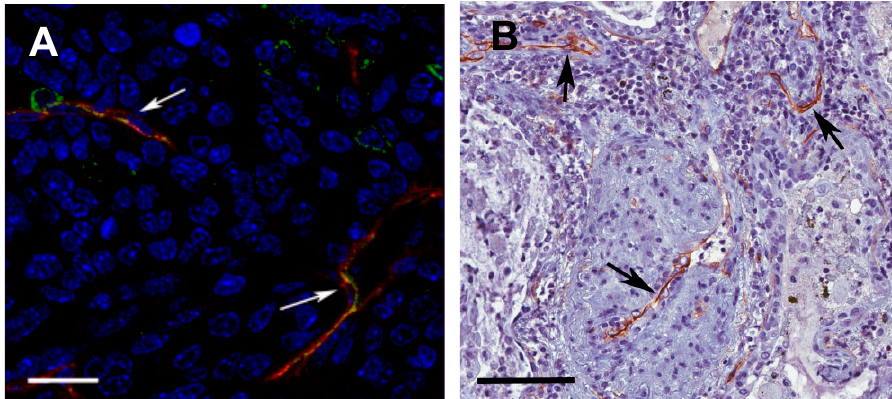
Figure 4. Expression of L1CAM in tumor vessels. ( A ) Mouse orthotopic, syngeneic model of pancreatic carcinoma (Panc02 cells transplanted into the head of the pancreas) co-stained for the vascular marker CD31 (red) and L1CAM (green). Scale bar, 15 μ m; ( B ) Human lung carcinoma stained for L1CAM (brown). Arrows indicate L1CAM-positive tumor vessels. Scale bar, 150 μ m. F.A. and U.C., unpublished data.